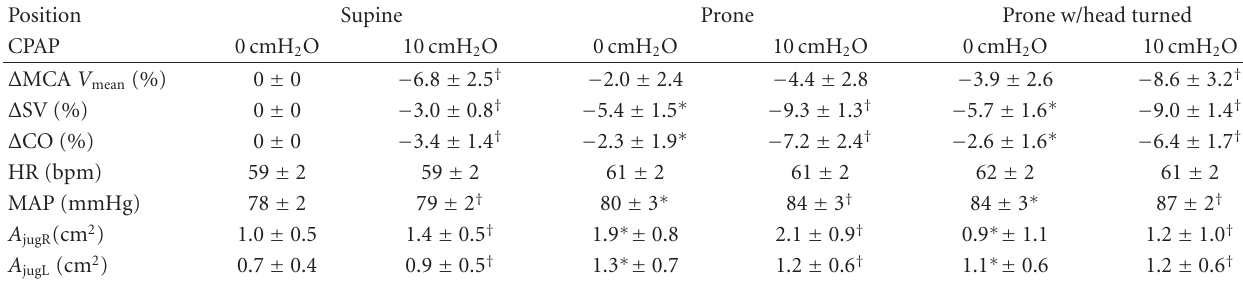
Table 1: Systemic and cerebral circulatory and jugular venous responses to continuous positive airway pressure (CPAP) at di ff erent body positions. Position Supine Prone Prone w/head